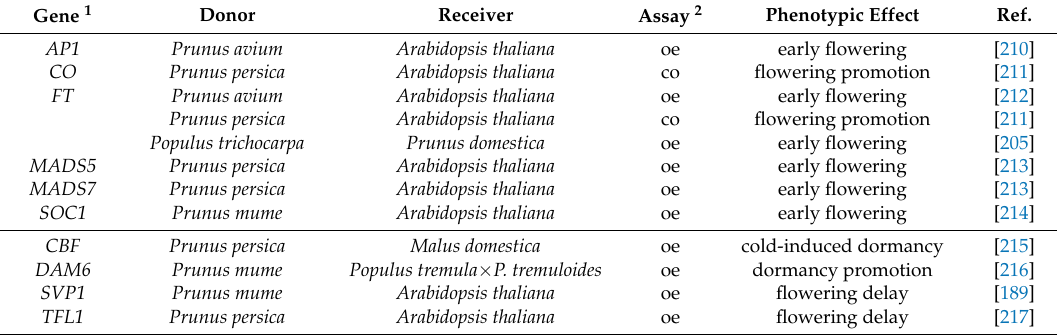
Table 2. Ectopic expression of some flowering genes from/into Prunus